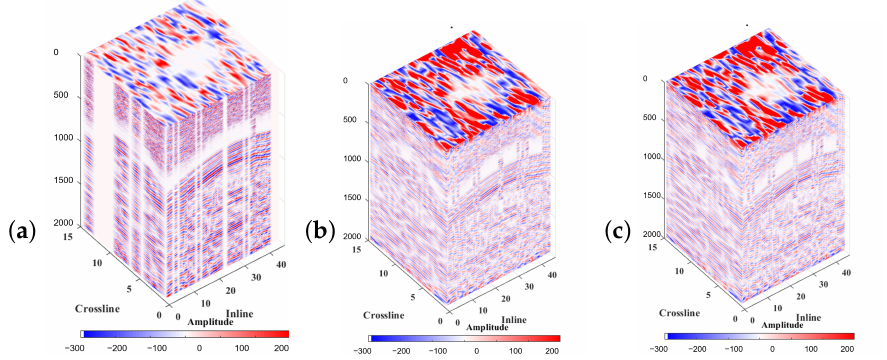
Figure 15. Cube of 3-D field data. ( a ) The input data. ( b ) Interpolation result of applying TRR.